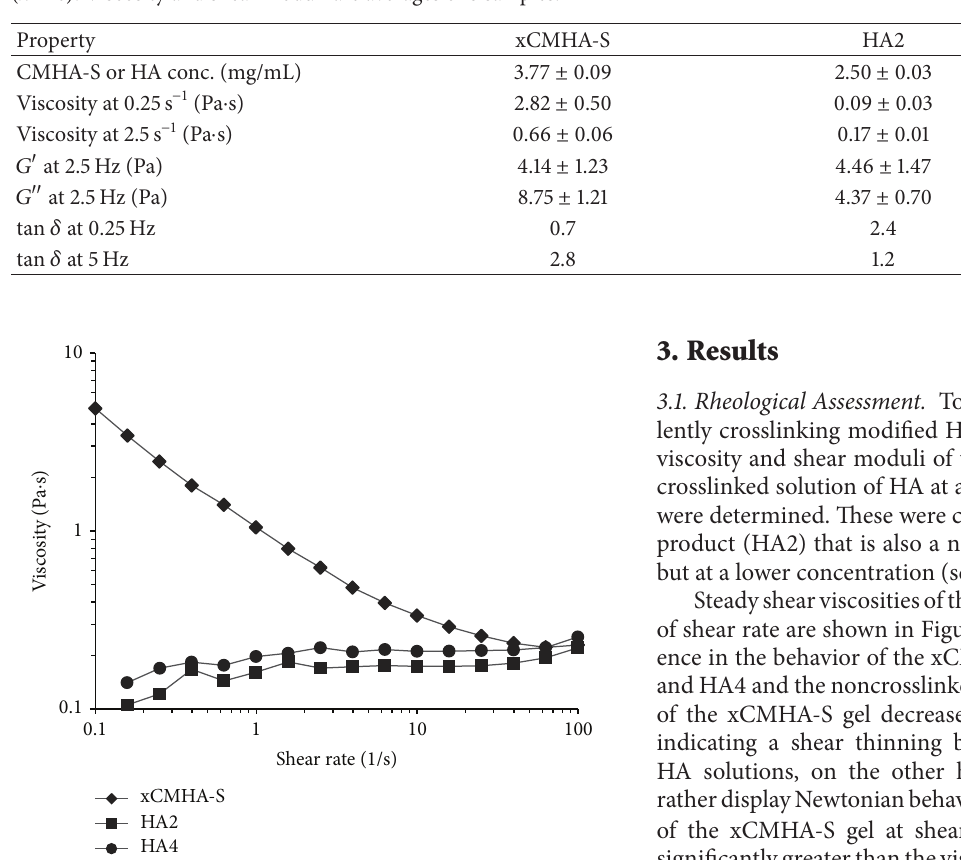
Figure 1: Steady shear viscosity of the crosslinked CMHA-S gel (xCMHA-S) and noncrosslinked HA solutions (HA2 and HA4) as a function of shear